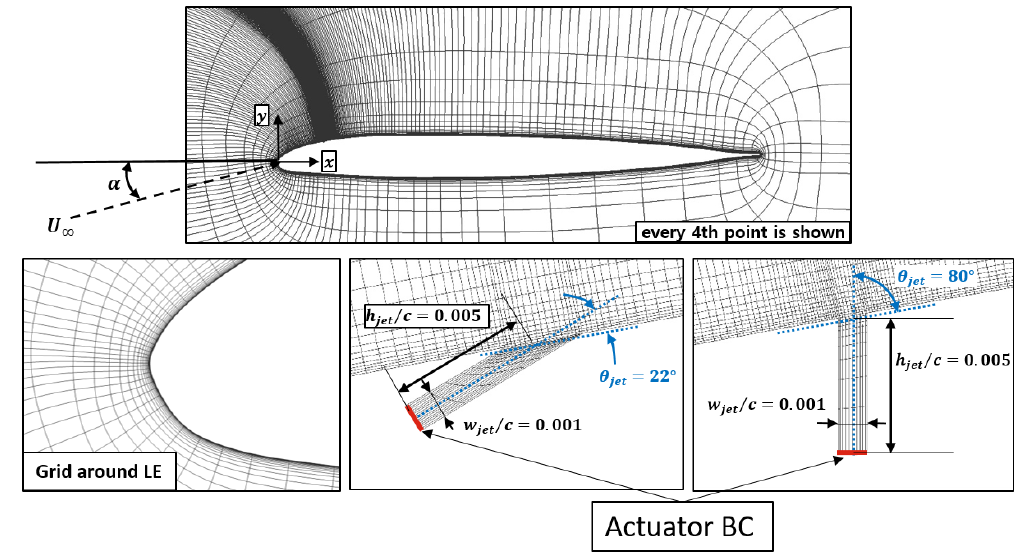
Figure 2. Grids around the OA209 airfoil, near the leading edge, and near the jet slots. Every 4th point is